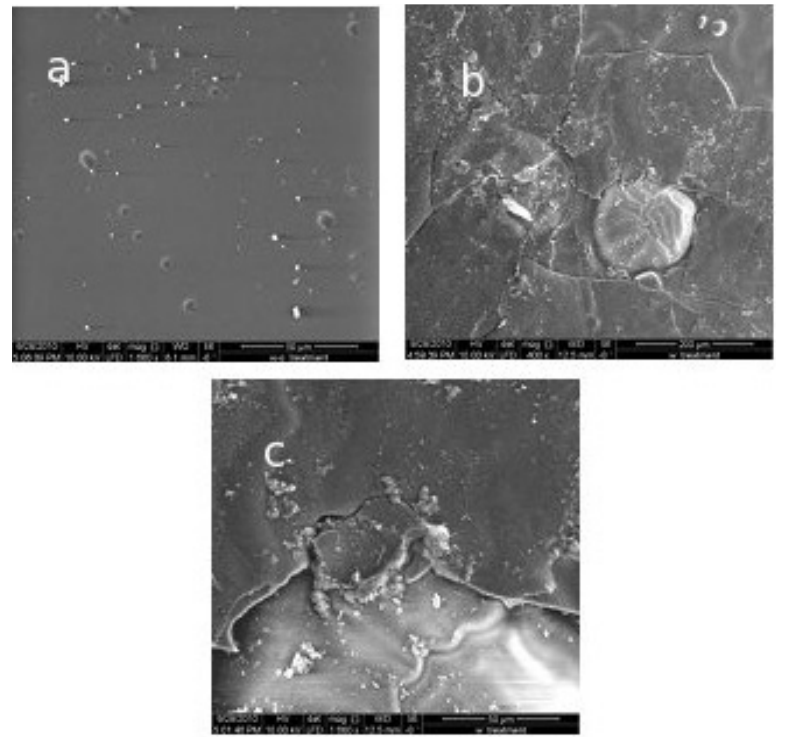
Figure 4. SEM images of PDMS surfaces. ( a ) Surface of untreated PDMS before immersion into piranha solution; ( b ) Oxidized surface of PDMS after excessive exposure in piranha solution at 400 × magnification; ( c ) SEM image of cracks as seen in Figure 2(b) at 1,600 ×